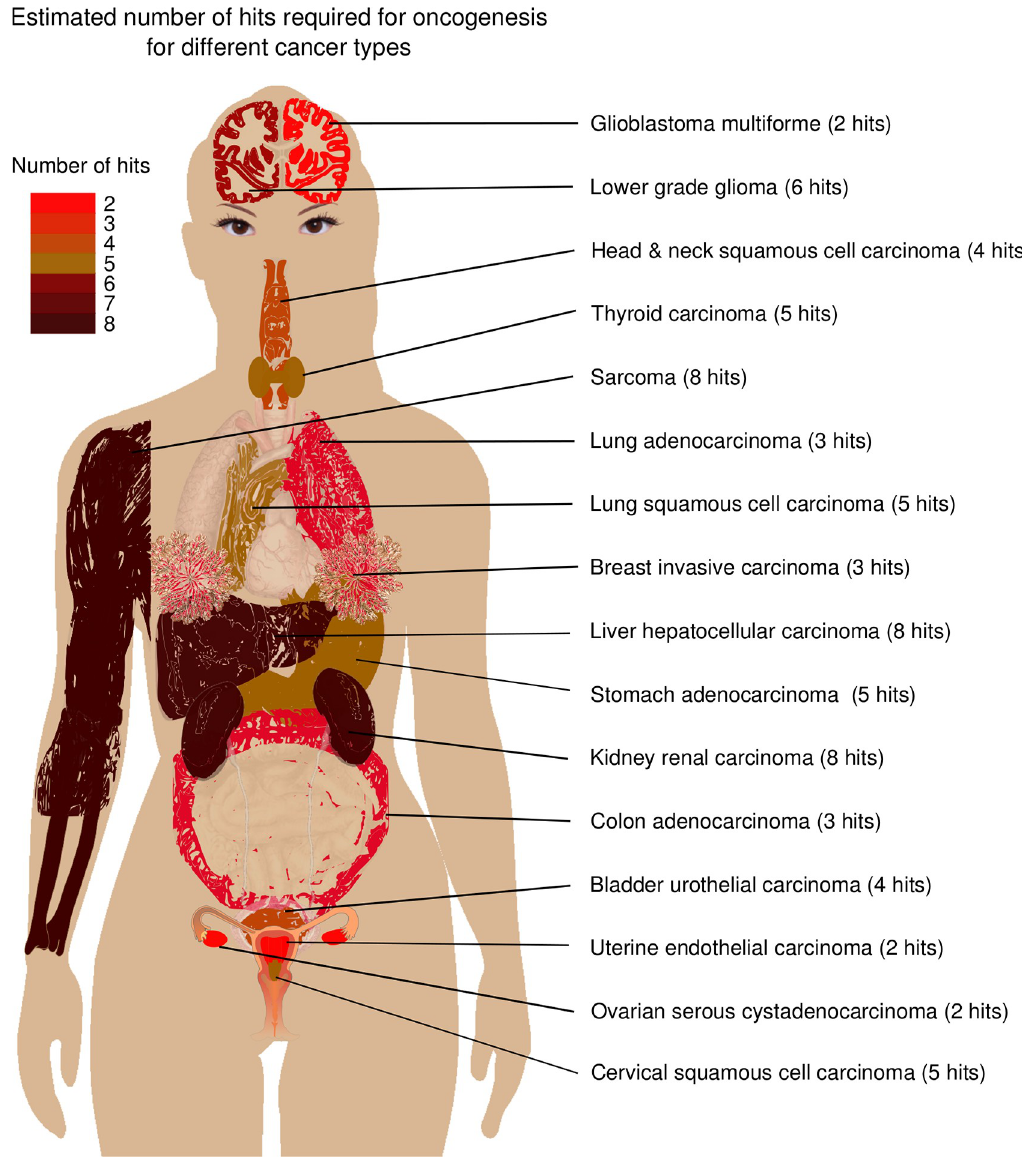
Fig 4. Graphical summary of estimated number of hits by cancer type. Derived from the public domain image by M Haggstrom (2014). head and neck squamous cell carcinoma (HNSC) the minimum RMSD for the 4-hit model is 2.03 compared to 2.06 for the 5-hit model. To assess the effect of a mix of different number of hits, we identified the optimal pairwise combination of hits from two to nine for each cancer type. The combined probability for a mix of a % hi-hits and (100- a )% hj-hits was calculated as ( a . P + (100 − a ). P )/100. The RMSD between the actual and calculated distributions P hihj = hi hj were lower in all cases with the maximum RMSD being reduced from 2.1 to 1.7 (Table 1). For THCA, for example, a mix of 40% 3-hit combinations and 60% 8-hit combinations fit the dis- tribution with RMSD of 0.85 compared to the 5-hit combination with RMSD 1.69. For PRAD, a mix of 30% 6-hit combinations and 70% 8-hit combinations fit the distribution with RMSD